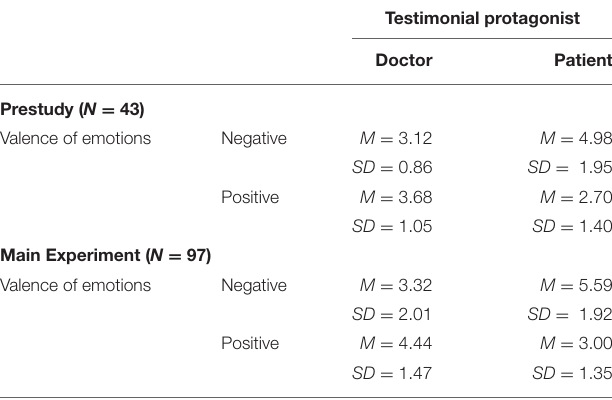
TABLE 2 | Summary of main results regarding experienced valence of emotions when presenting information of negative content in the Prestudy ( N = 43) and the Main Experiment ( N =